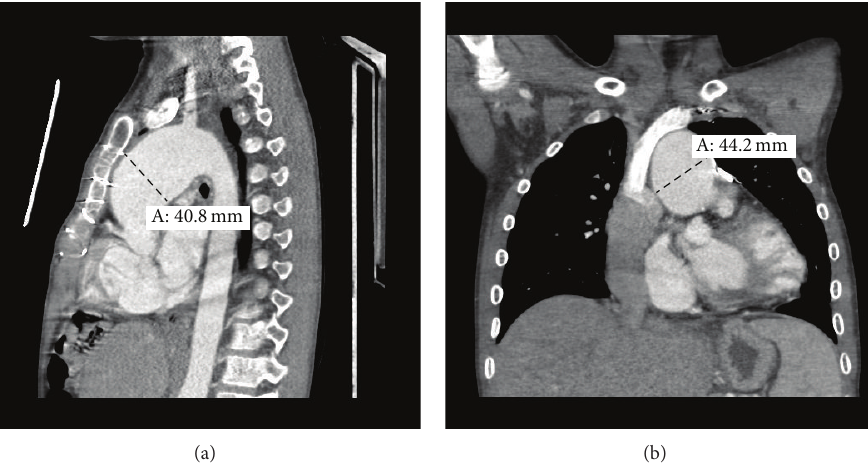
Figure 1: Optiray contrast-enhanced computed tomography images of the chest with sagittal (a) and coronal (b) reconstructions in the 14-year-old proband revealing aneurysmal dilation of the ascending aorta.